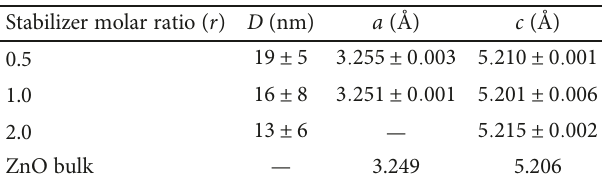
Table 3: Evaluated structural parameters of the propanol-derived ZnO fi lms at di ff erent MEA molar ratios compared with the